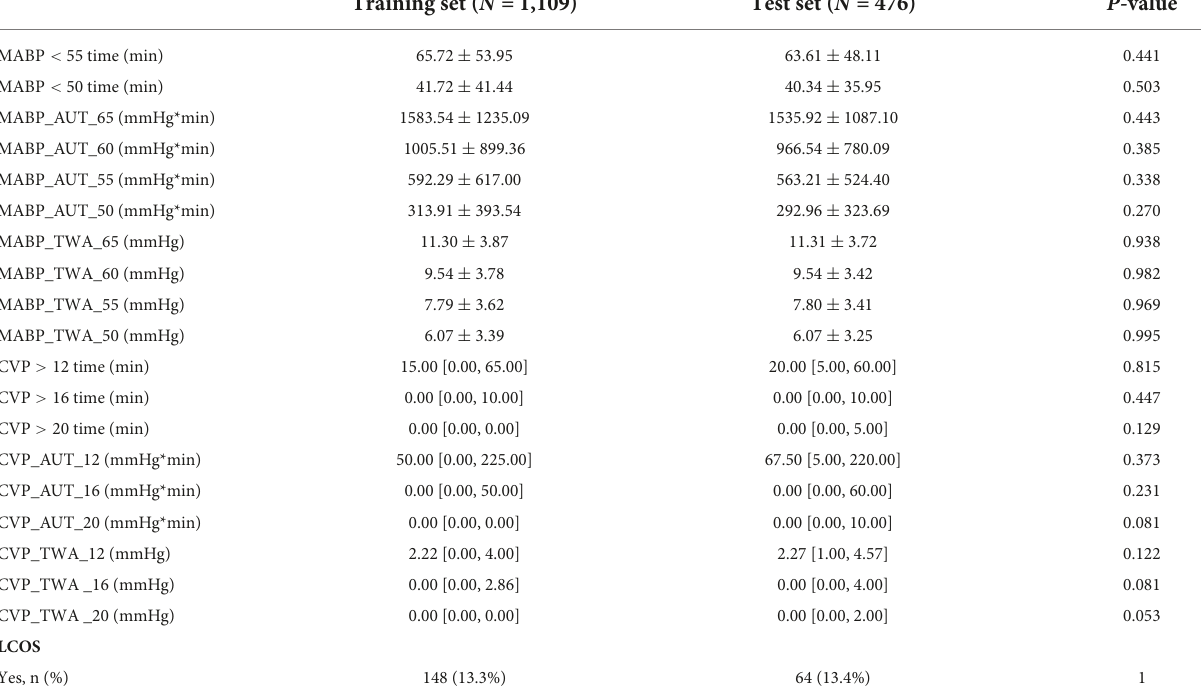
The SHAP summary plot ( Figure 3 ) and dependence plot ( Figure 4 ) represented the contributions of these eleven variables to the prediction of the RF model, with SHAP values above zero indicating an increased risk of developing LCOS and SHAP values below zero indicating a decreased risk of LCOS. For example, SHAP values for high LVEF (red) were usually less than zero, indicating a decreased risk of LCOS in patients with higher LVEF. In addition, Figure 3A displays the ranking of the features based on the average absolute SHAP value. Among the eleven variables, LVEF, Lac,